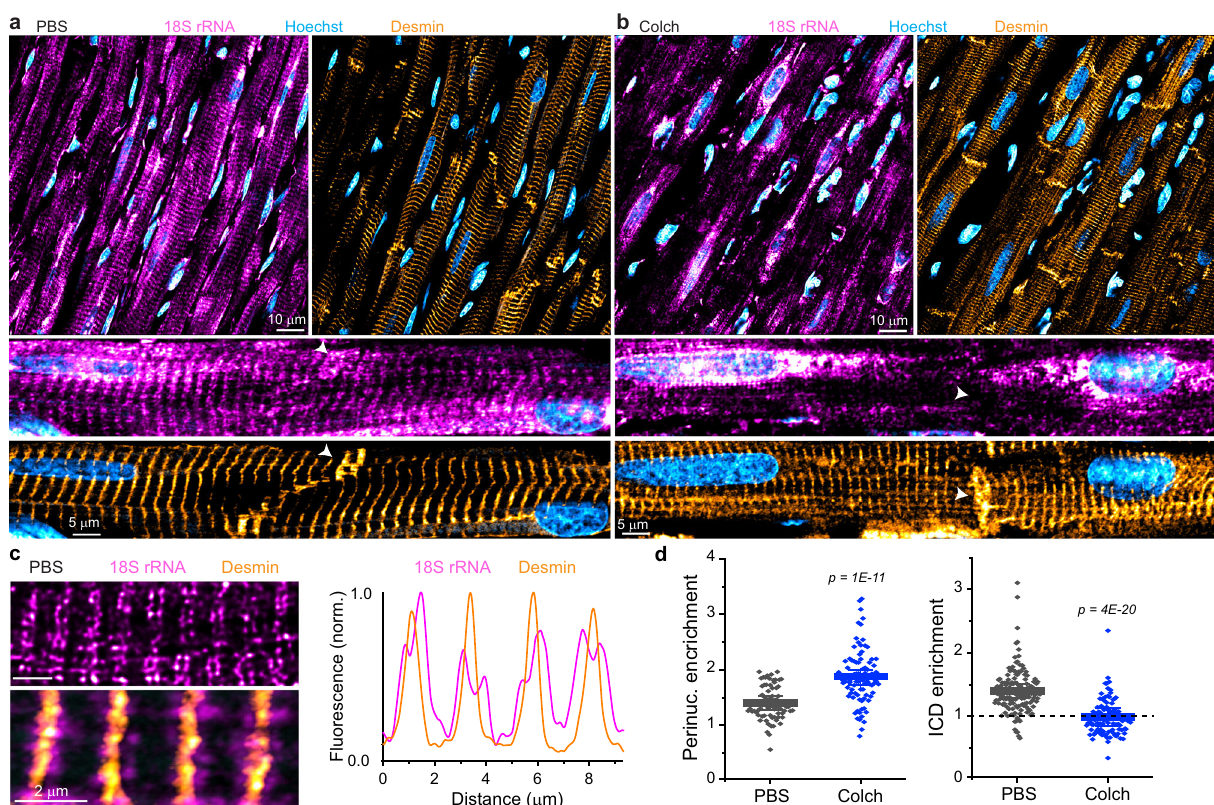
Fig. 5 Microtubules control the localization of ribosomes in vivo. a Representative image of PBS-injected rat ventricular myocardium, with zoomed-in image below and white arrow highlighting ICD region. b Representative image of Colch-injected rat ventricular myocardium with similar zoom and highlight as in a . c (left) Zoomed-in image of PBS-injected rat ventricular myocardium. (right) Line scan analysis of the composite image shown at bottom left. d Nuclear:cytosolic and ICD:cytosolic ratios of 18S rRNA mean fl uorescence intensities of experiment depicted in a and b . PBS ( N = 2), ( n = 71, N/C), ( n = 137, ICD/C), Colch ( N = 2), ( n = 92, N/C), ( n = 108, ICD/C). Statistical signi fi cance determined via two sample, two-tailed t -test. For all graphs shown in fi gure, the mean line is shown, with whiskers denoting standard error (SE) from the mean. Source data are provided as a Source data fi